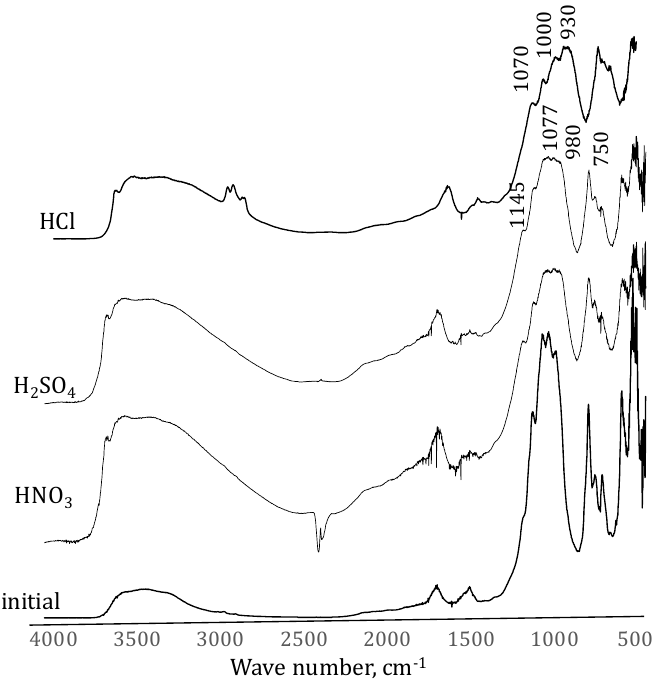
Figure 3. IR spectra of the initial eudialyte and of the sample after the interaction with HCl, H 2 SO 4 , and HNO 3 .